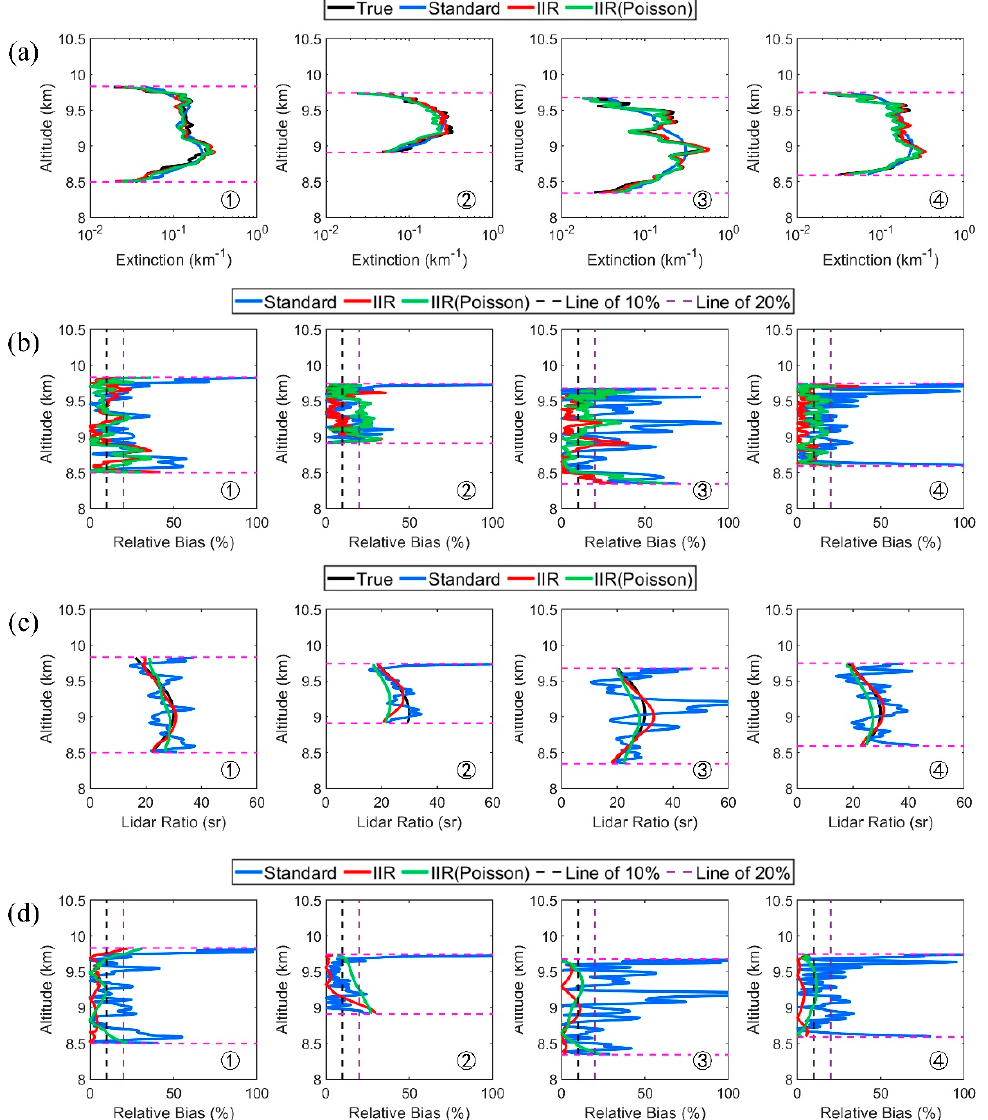
Figure 5. Comparisons of the extinction coe ffi cient and the lidar ratio obtained by di ff erent methods. ( a ) The profiles of the extinction coe ffi cient, whose profile numbers are 19, 48, 78, and 99, respectively. The lines in black are the true values, while the blue, red, and green lines represent the results obtained by the standard method, the IIR method, and the IIR method based on the Poisson model, respectively. The area within the dotted pink line is the valid area of clouds. ( b ) The relative biases of the extinction coe ffi cient. The blue, red, and green lines represent the relative biases obtained by the standard method, the IIR method, and the IIR method based on the Poisson model, respectively. The black dotted line represents a relative bias of 10 percent, while the yellow dotted line represents a relative bias of 20 percent. The area within the dotted pink line is the valid area of the clouds. ( c ) and ( d ) represent the profiles of lidar ratio and the relative bias of the lidar ratio, respectively.